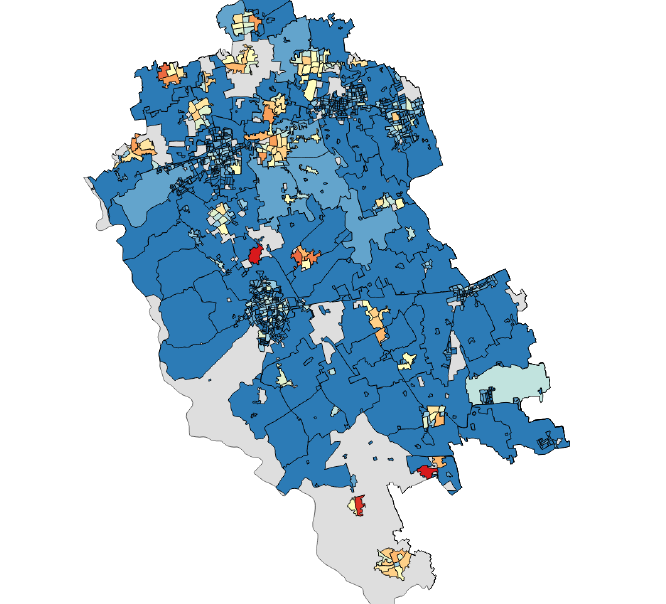
Figure 15. Map of the willingness to pay for home heating (€/year) (Magentino-Abbiatense